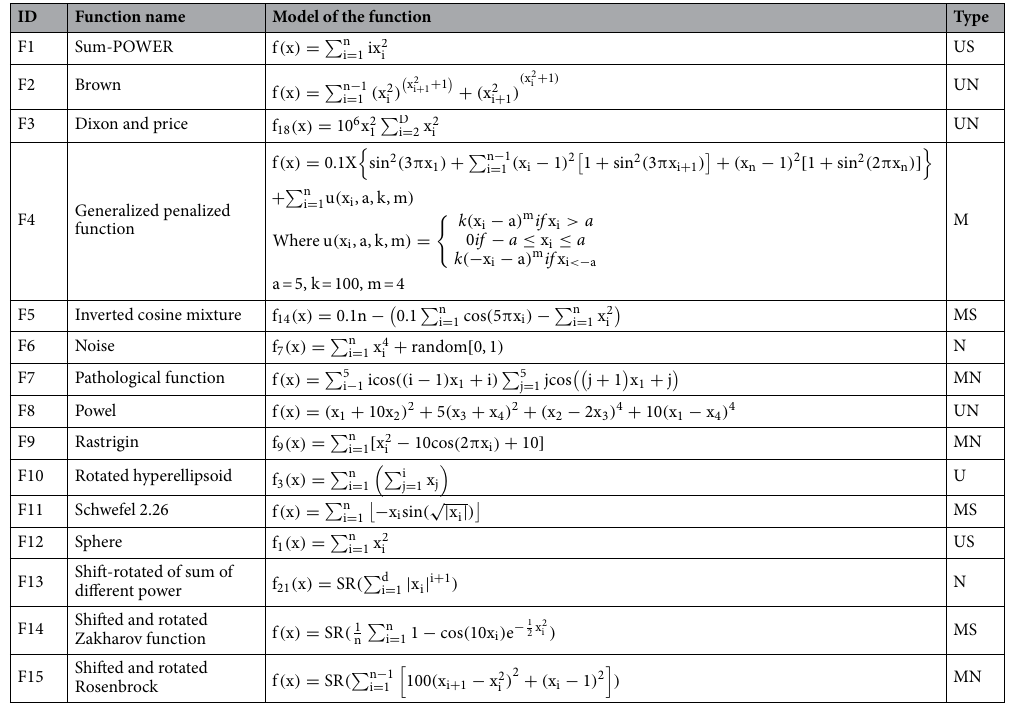
Table 2. Classical benchmark functions used to evaluate the IEOSA method, where Dimension (D), Multimodal (M), Non-separable (N), Unimodal (U), and Separable (S) describe entry in the “Type” column.